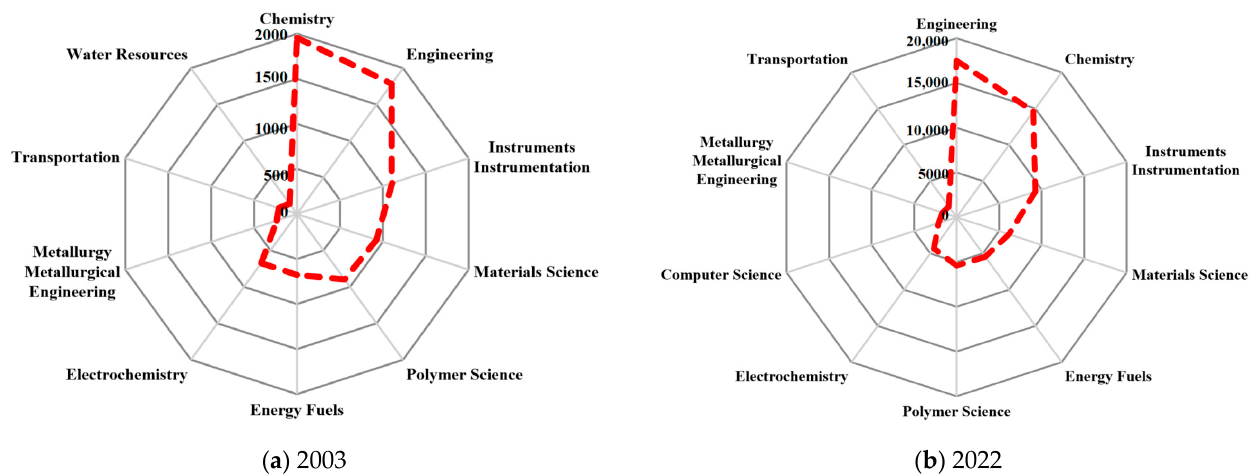
Figure 3. Global radar map of CCUS subject fields in 2003 and 2022.